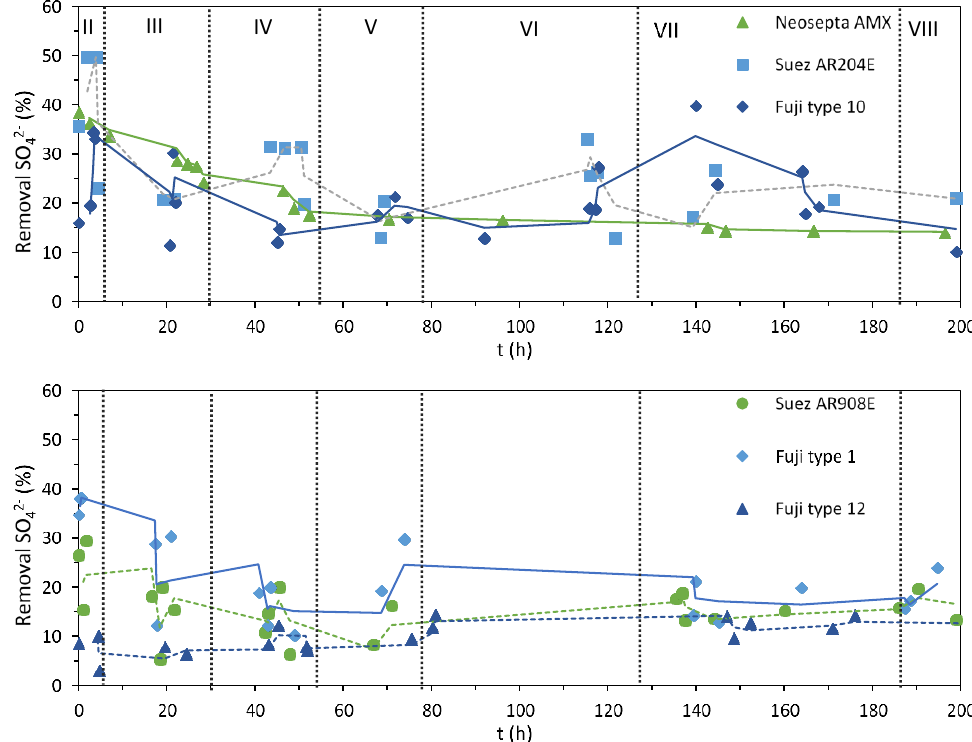
Figure 5. Measured sulfate removal vs. time for each stack. Each data point was calculated from the average changes in sulfate concentration in both the diluate and the concentrate stream. Continuous trendlines (calculated as moving average) are included only for guiding the eye.